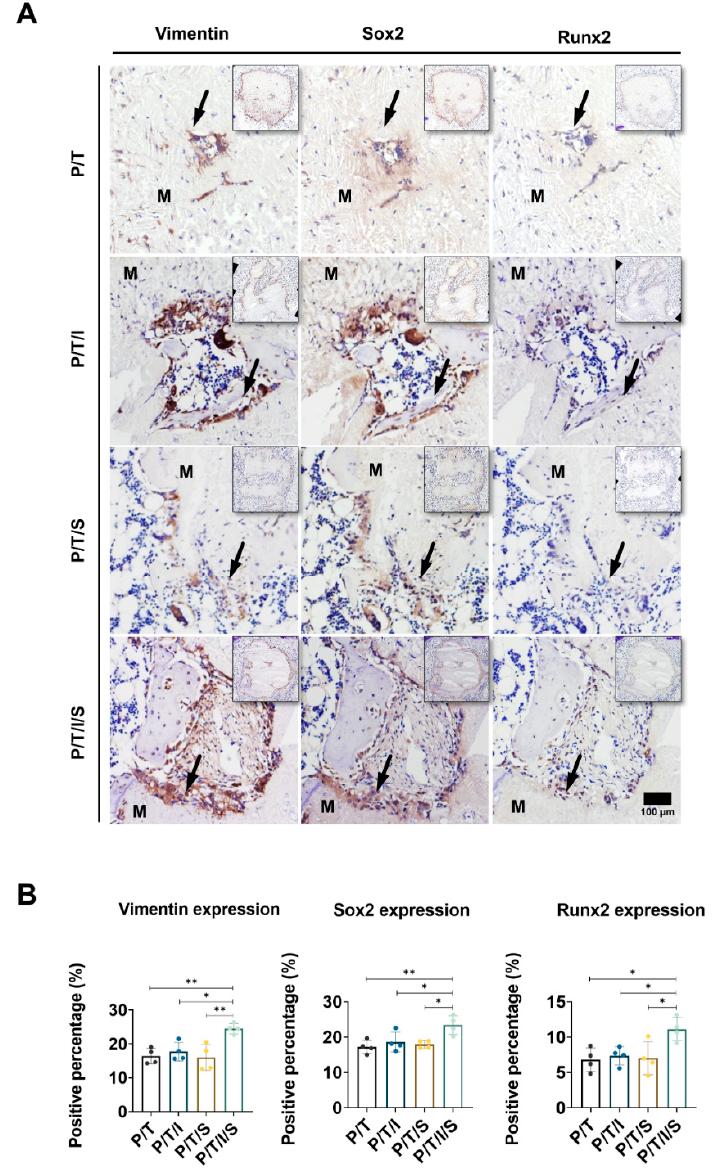
Figure 6. Expression of cellular adhesive, pluripotent, and osteogenic markers in femoral bone defect at week 4. ( A ) IHC staining for Vimentin, Sox2, and Runx2 on adjacent sections 5 µ m apart. Black arrows indicate the positive signal of the target protein. M: materials. ( B ) Semi-quantitative analysis of Vimentin, Sox2, and Runx2 expression at defect sites shown in ( A ). Data are shown as mean ± SD (* p < 0.05, ** p < 0.01, one-way ANOVA with Tukey’s HSD, n =